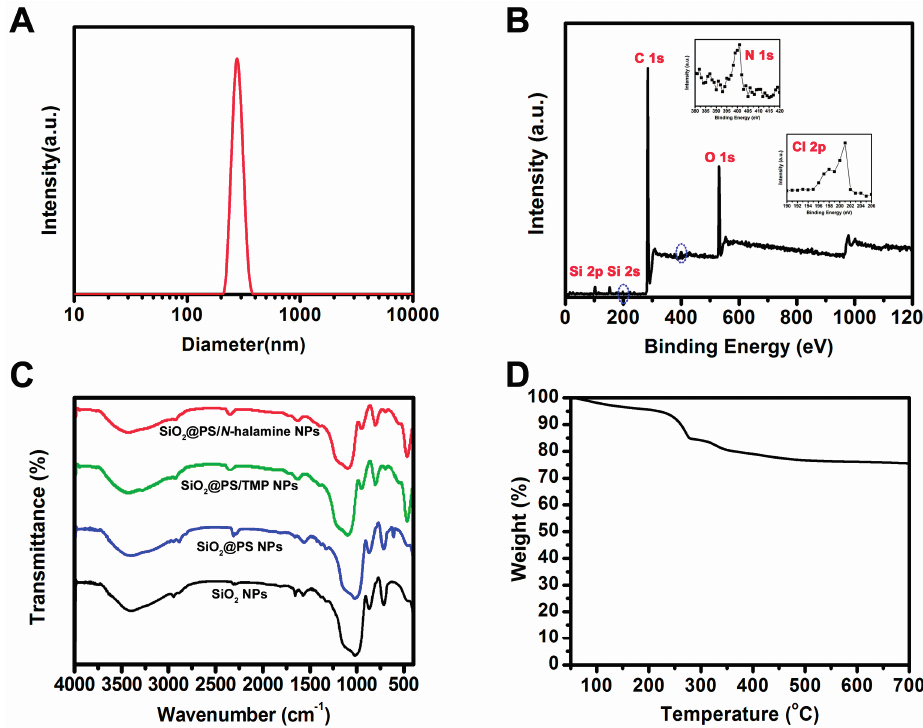
Figure 2. ( A ) DLS analysis and ( B ) XPS spectrum of SiO 2 @PS/ N -halamine